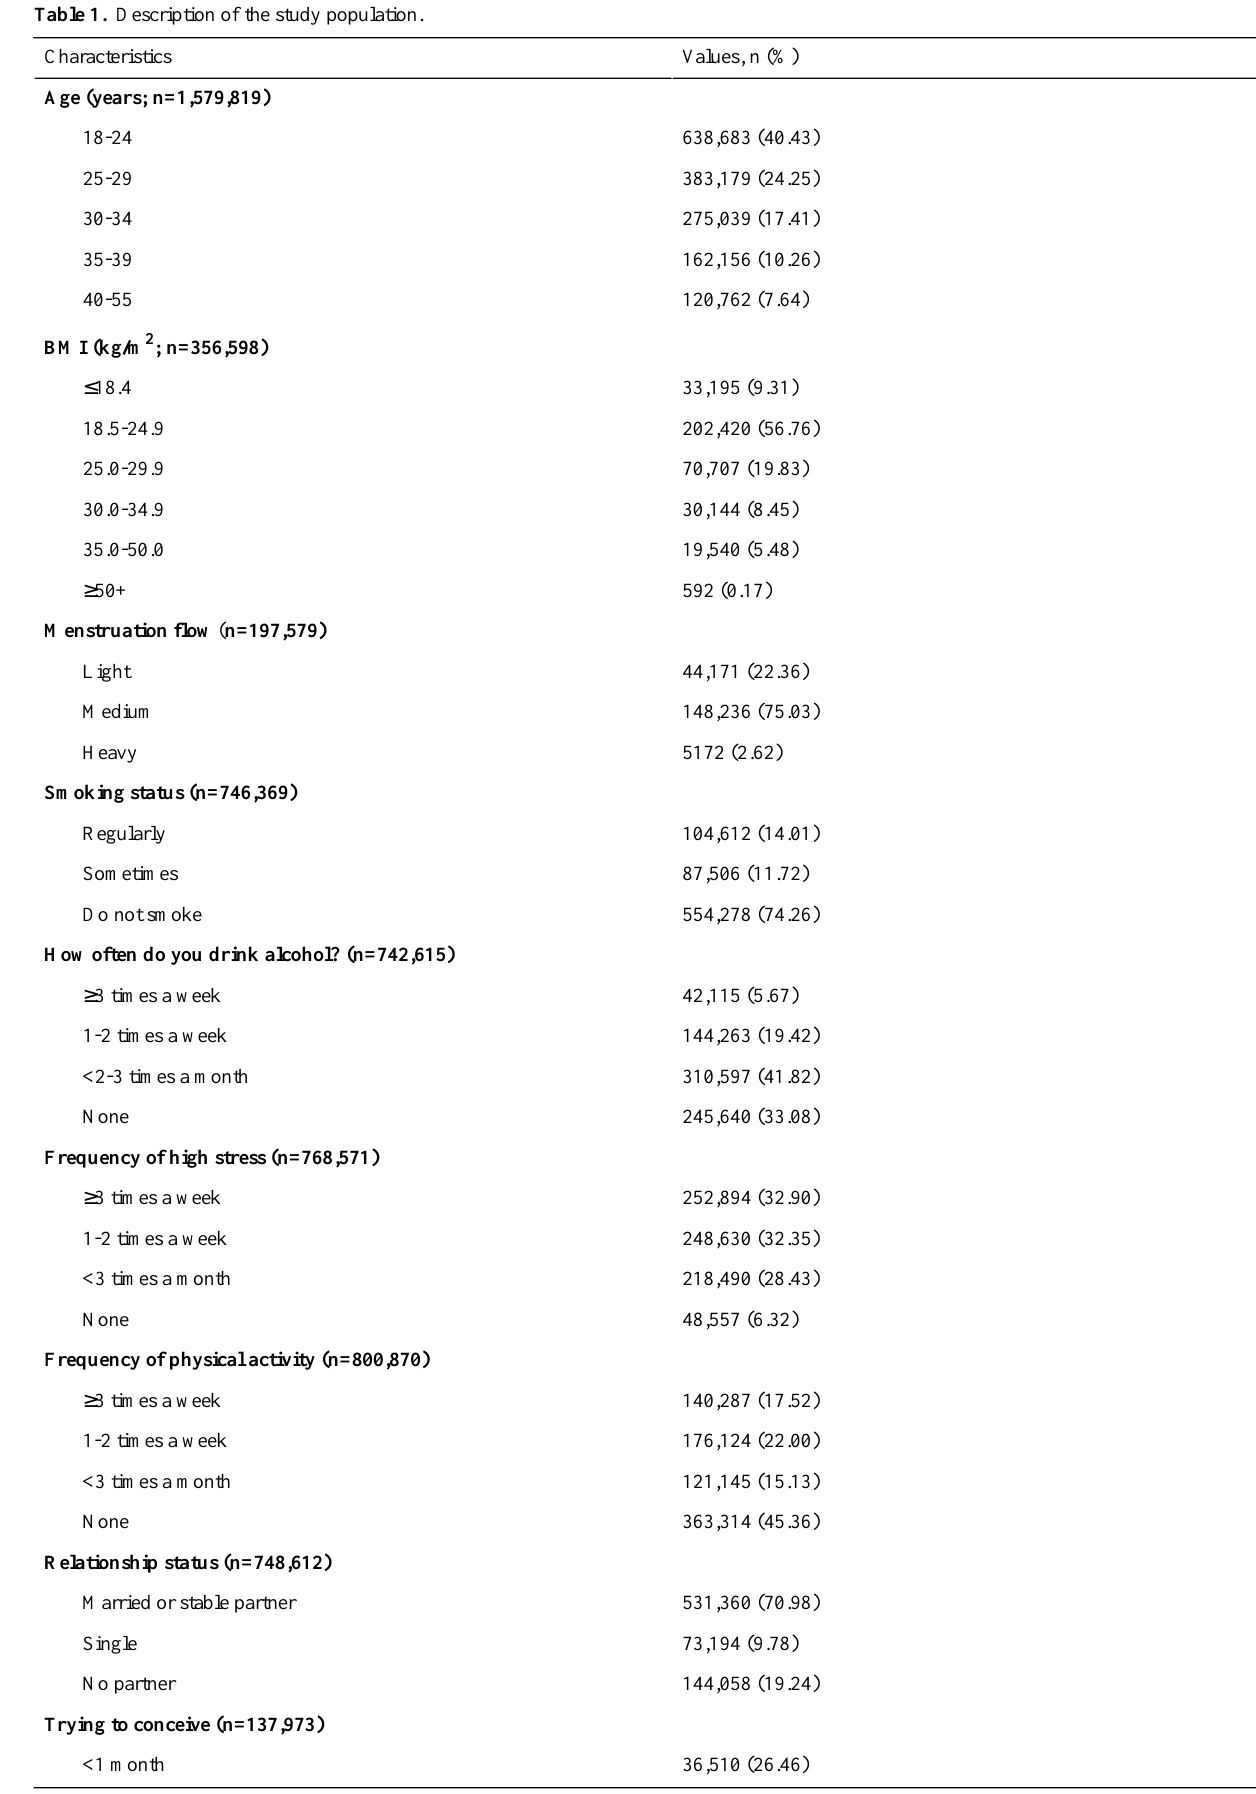
Table 1. Description of the study population.